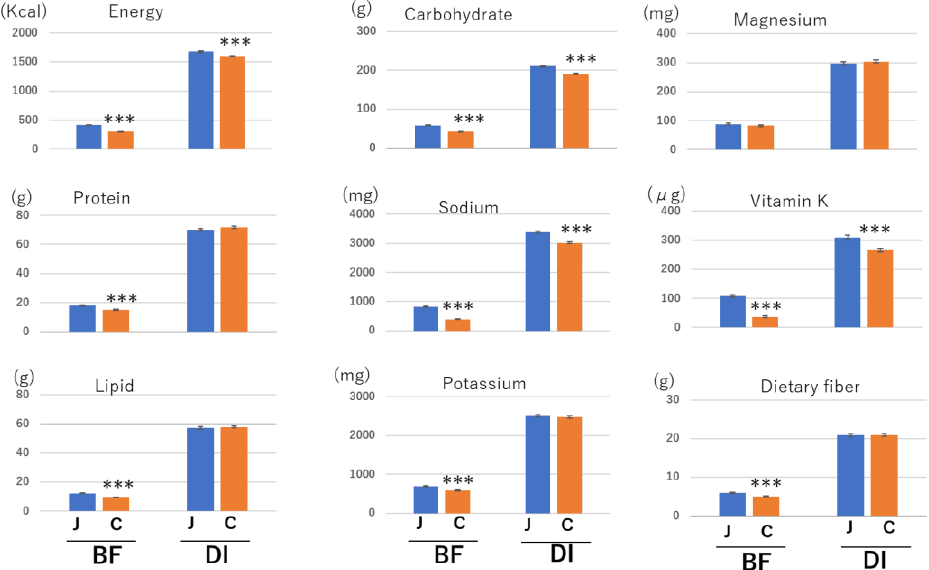
Figure 2. Intake of each nutrient in Japanese or cereal breakfast styles at breakfast and daily intake. All data were obtained from women. The columns represent the mean and standard errors. Two-group differences were statistically analyzed using the Student’s t -test. *** p < 0.001. J — Japanese meal; C — cereal meal. BF — breakfast; DI — daily intake.